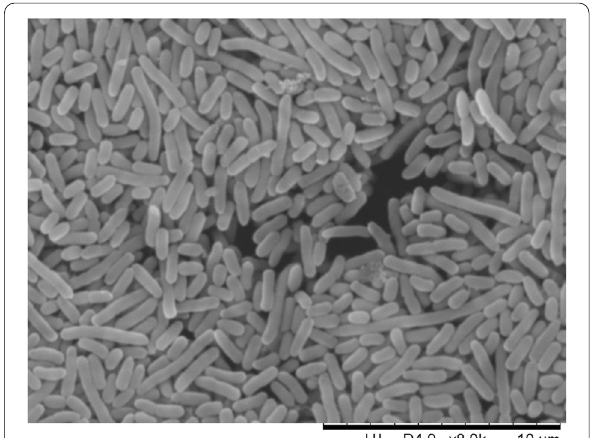
Fig. 1 Scanning electron micrograph of Pseudomonas putida LWPZF